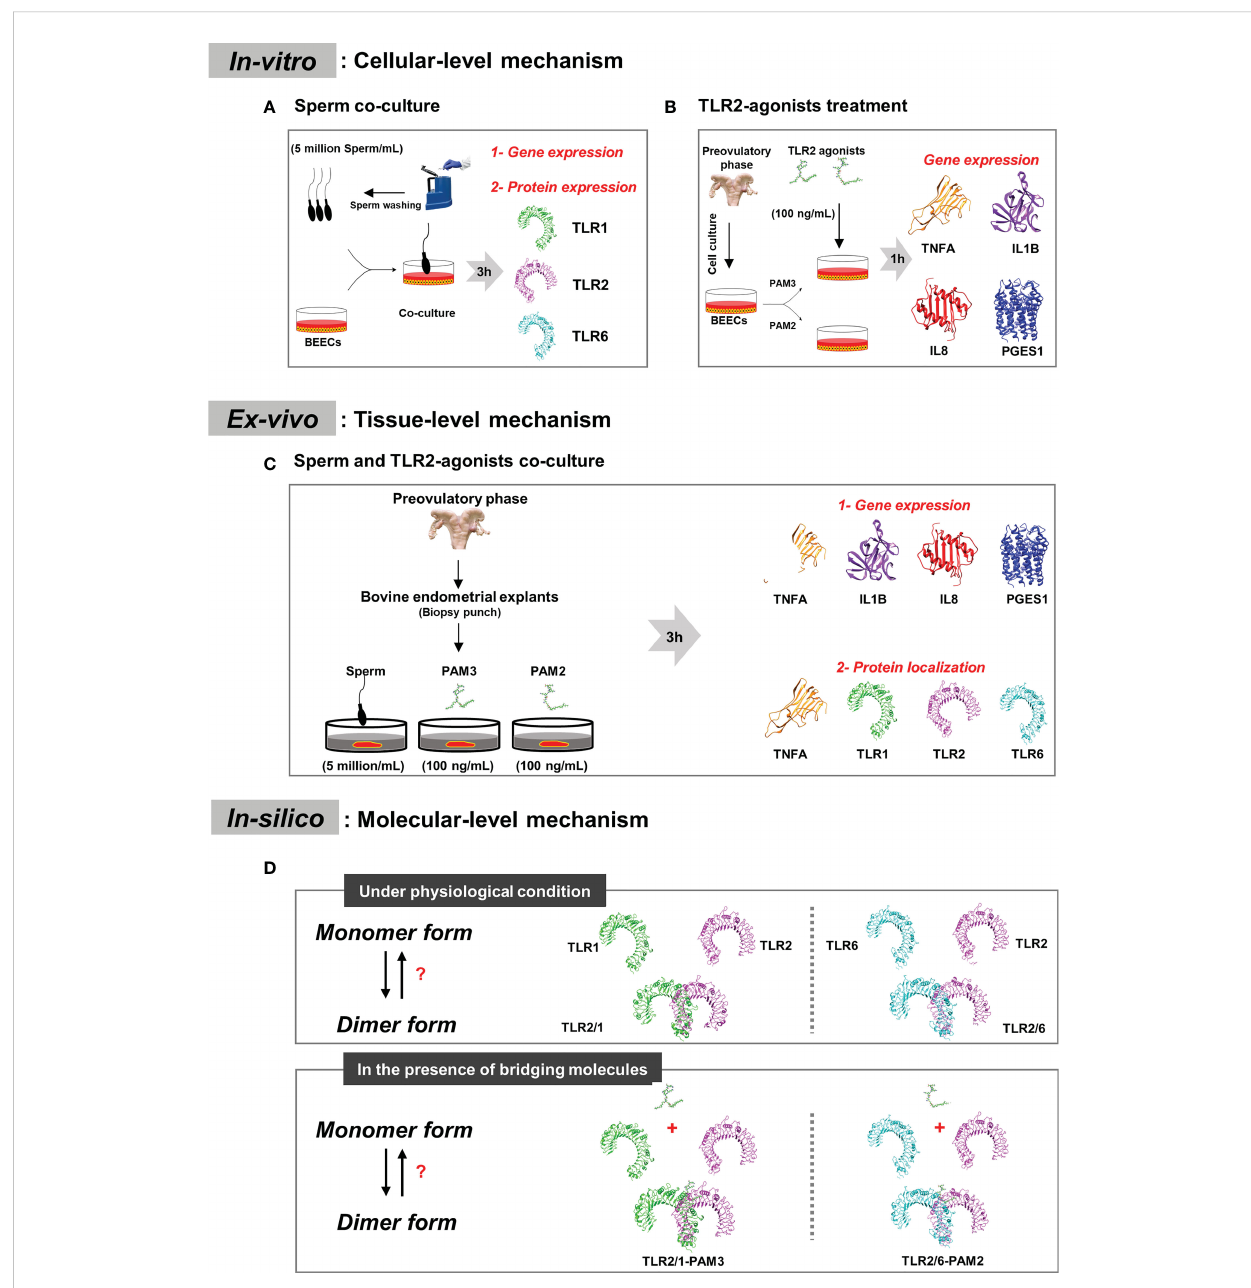
FIGURE 1 Plan representation of the research design. (A) In-vitro model: to detect which active TLR2 dimer can be employed by sperm in bovine endometrium at cellular level. BEECs monolayer were co-cultured with 5million sperm per mL for 3h. qRT-PCR and immunostaining analyses were done to investigate TLRs mRNA and protein expression. (B) In-vitro model: to study in fl ammation intensity through the two classical TLR2 signaling (TLR2/1 and TLR2/6 signaling cascades), BEECs monolayer were stimulated with 100 ng/mL of PAM3 (TLR2/1 agonist) and PAM2 (TLR2/6 agonist) for 1h. A time-dependent experiment (1, 6 and 12h) was done to con fi rm the difference between both TLR2 signaling pathway. Finally, qRT-PCR analysis was performed to consider the pro-in fl ammatory mRNA expression ( TNFA , IL1B , IL8 and PGES1 ). (C) Ex-vivo model: to compare sperm induced in fl ammation in endometrium with PAM3 and PAM2. Bovine endometrial explants were co-incubated with 5milion sperm/mL, and 100 ng/mL PAMs for 3h. First, qRT-PCR was employed to investigate the pro-in fl ammatory mRNA expression. Afterwards, immunostaining was used to evaluate and localize the strong in fl ammatory marker (TNFA) for all groups and signaling marker proteins (TLR1, TLR2 and TLR6) in endometrium for sperm group. (D) In-silico model: we investigated dimerization process for TLR2 in different condition, in absent and presence of TLR2 agonists. Additionally, we predict the effect of agonist on bovine TLR